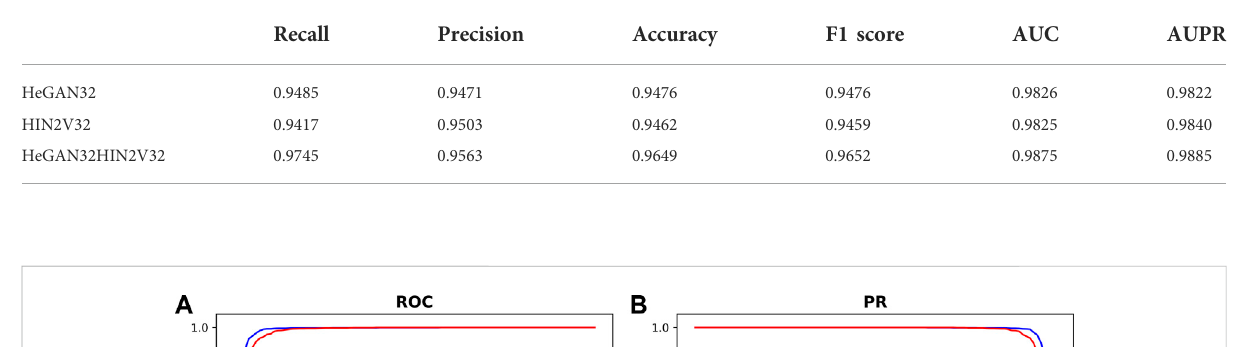
TABLE 4 Ablation study results of different feature vector models.